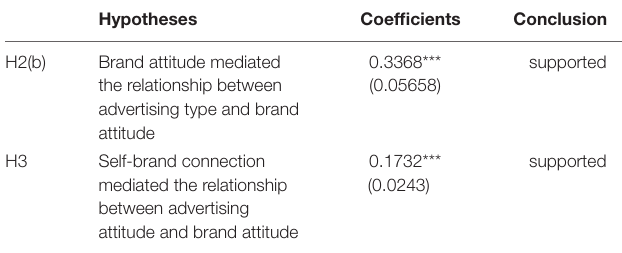
TABLE 6 | Hypotheses test results.